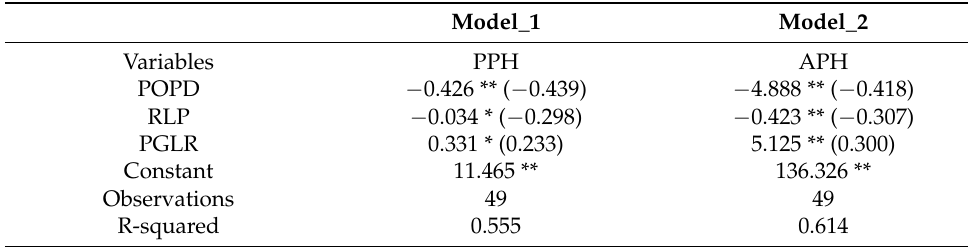
Table 5. Results of OLS